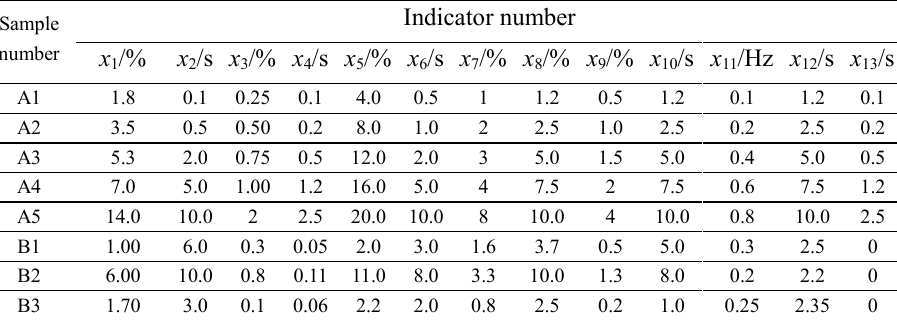
Table 2. Original monitoring data.